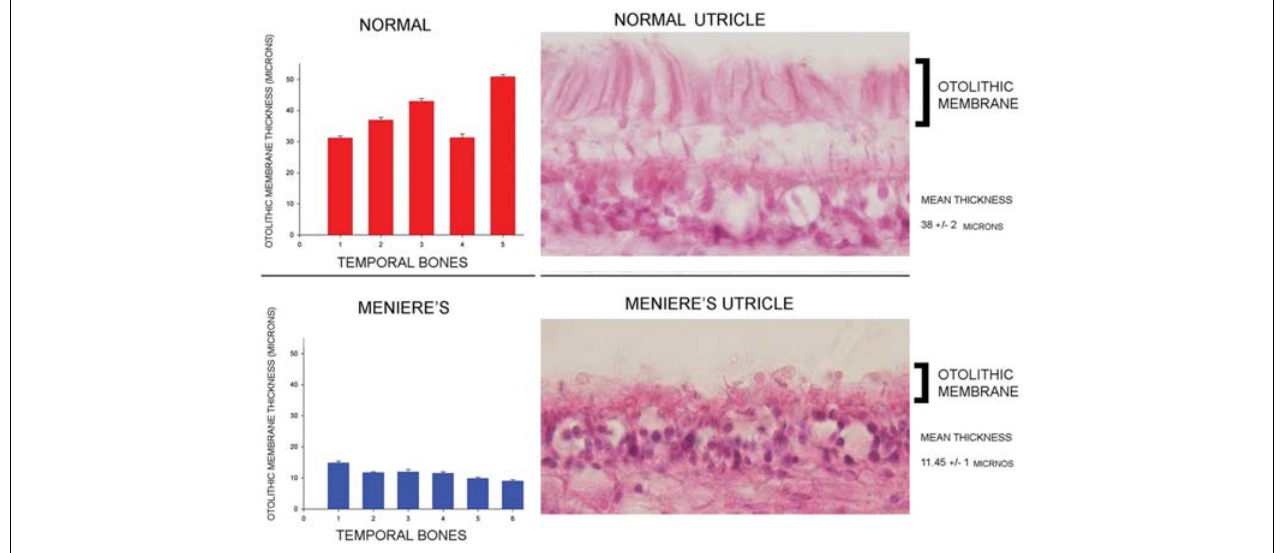
FIGURE 11 | Thickness of the human Otoconial Layer. The Normal Utricle photomicrograph shows otoconial layer thickness values from five specimens; The lower Menière’s utricle showing diseased macula with a much thinner otoconial layer, photomicrograph and OL thickness for six specimens. Reproduced by permission from Ishiyama et al.